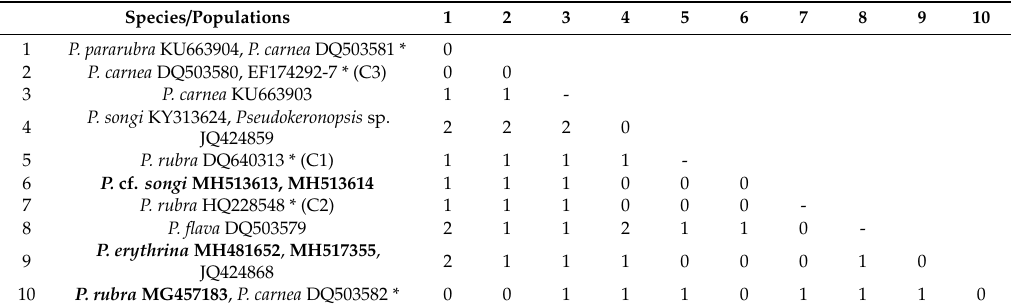
P. rubra MH513652 , P. songi KY313624, P. rubra DQ640313* P. rubra HQ228548 P. carnea DQ503580* P. sp. JQ424859, (C1) (C2) EF174292-4* (C3), DQ503582*, EF174295-7*, P. flava Figure 3. Secondary structure features of the Pseudokeronopsis ITS2 molecule. ( A ) Consensus secondary structure predicted using the LocARNA Sever. Color bars (0–1) indicate base-pairing probability. ( B ) Structural model for Pseudokeronopsis . ( C ) Helix A structures of congeners. Using the structure of P. carnea as a reference, compensating base changes (CBCs) are marked with filled arrows and hemi-CBCs are indicated with hollow arrows. The variable region is marked by a grey box. Newly sequenced species are in bold. *, misidentified. Table 3. Compensating base changes of ITS2 between Pseudokeronopsis species /